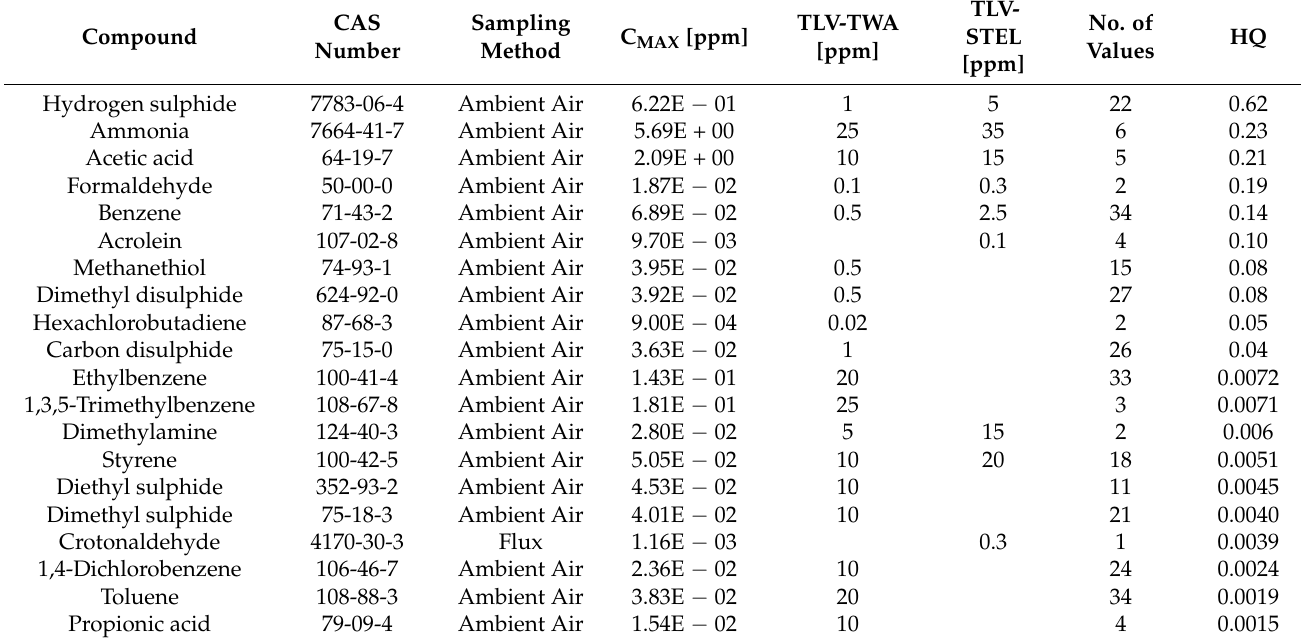
Table 3. Maximum concentration, number of values observed in the literature, TLV and HQ values relevant to the most critical compounds found in fresh waste